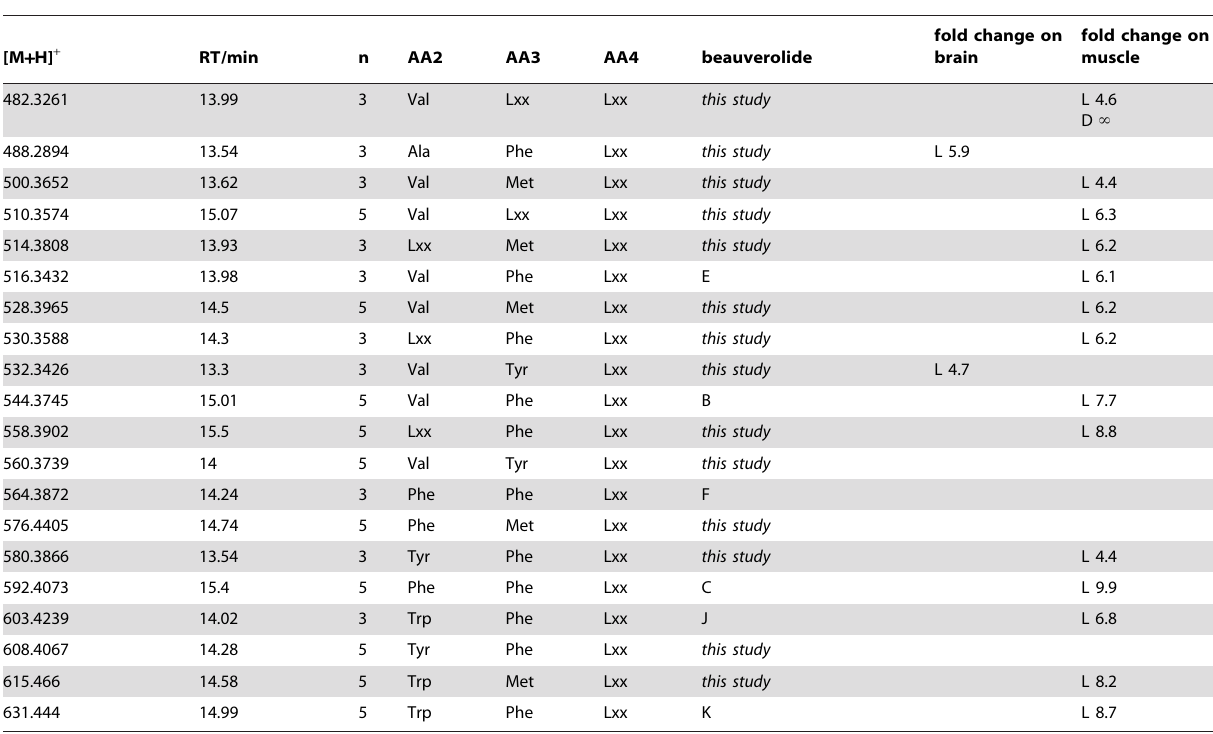
Table 1. Secreted beauverolides in the ex vivo culturing system.